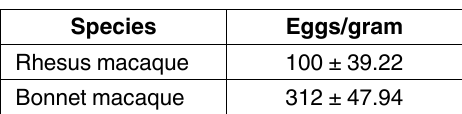
table 1. Eggs per gram of strongyle in